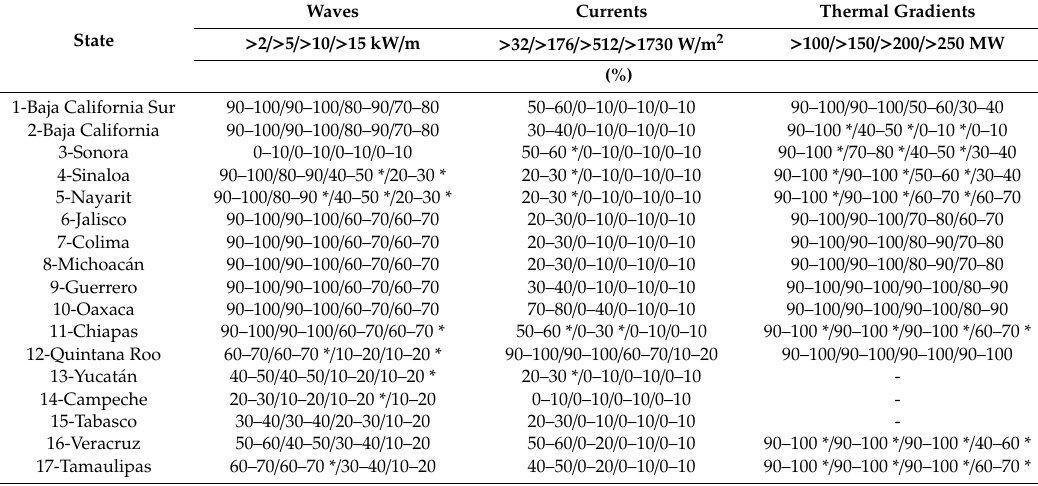
* = Regions located farther from the